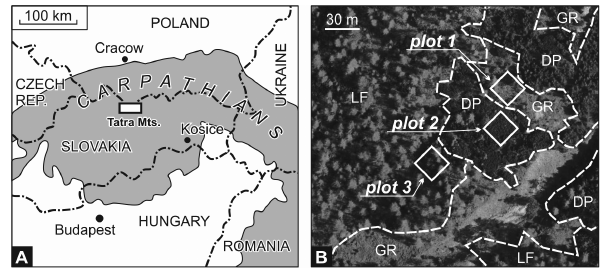
Figure 1. Location of the study area: (a) Tatra Mountains in the Carpathian mountain chain; (b) aerial photographs of the study area in Jaworzynka Valley with marked research plots: GR – mountain grassland (high mountain calcareous grassland: Carici sempervirentis–Festucetum tatrae association), DP – thickets of dwarf pine Pinetum mughi , LF – open (sparse) larch ( Larix sp.) forest with a dense cover of grass Calamagrostis sp. on the forest floor.